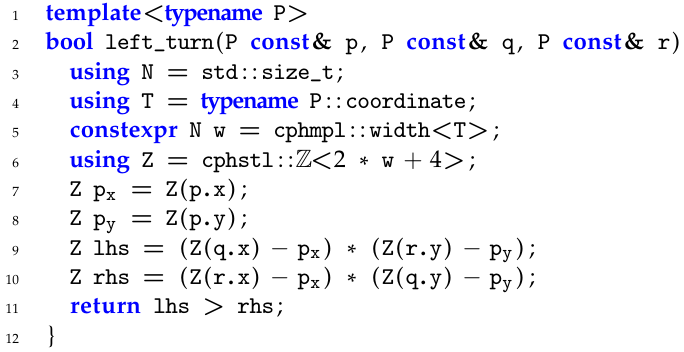
Figure 1. The left-turn predicate written in C ++ . The compile-time function cphmpl :: width < T > returns the width of the coordinates of type T in bits. The class template cphstl :: Z < b > provides fixed-width integers; the width of the numbers is b bits and, for numbers of this type, the same operations are supported as for built-in